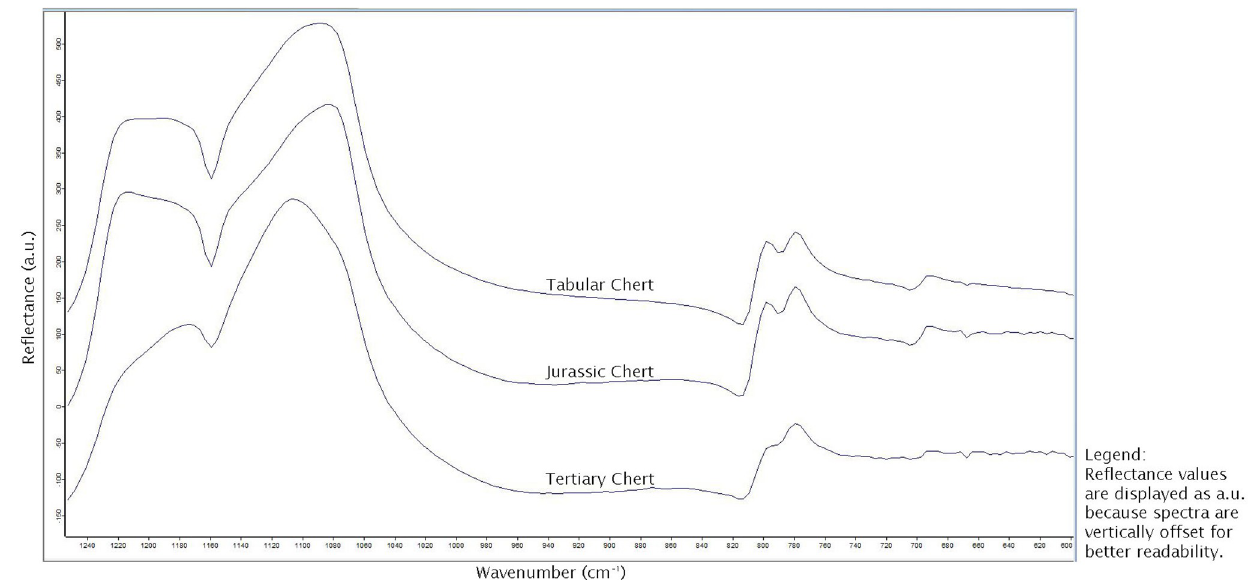
Fig 4. Example spectra of the three raw material outcrops tested.